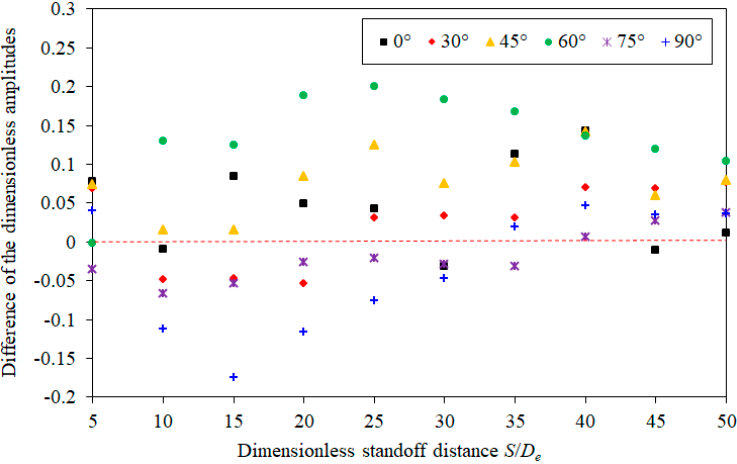
Figure 9. The differences in the dimensionless P max against dimensionless S . Figure 10. The differences in dimensionless amplitudes against dimensionless standoff distance.